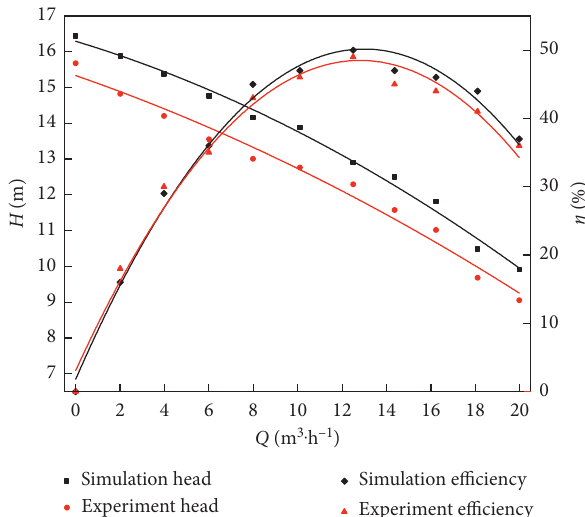
Figure 4: Verification of external characteristics of centrifugal